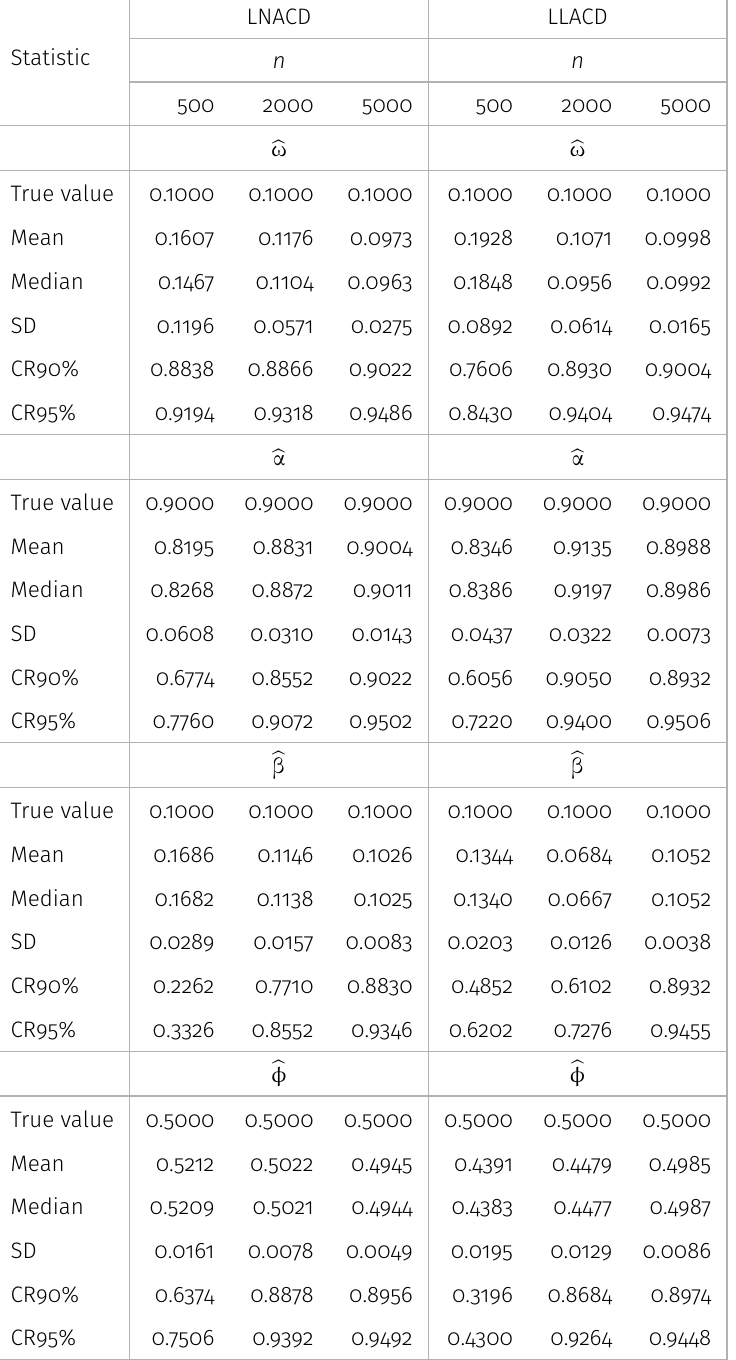
Table I. Summary statistics from simulated LNACD and LLACD data for the indicated estimators and nnn